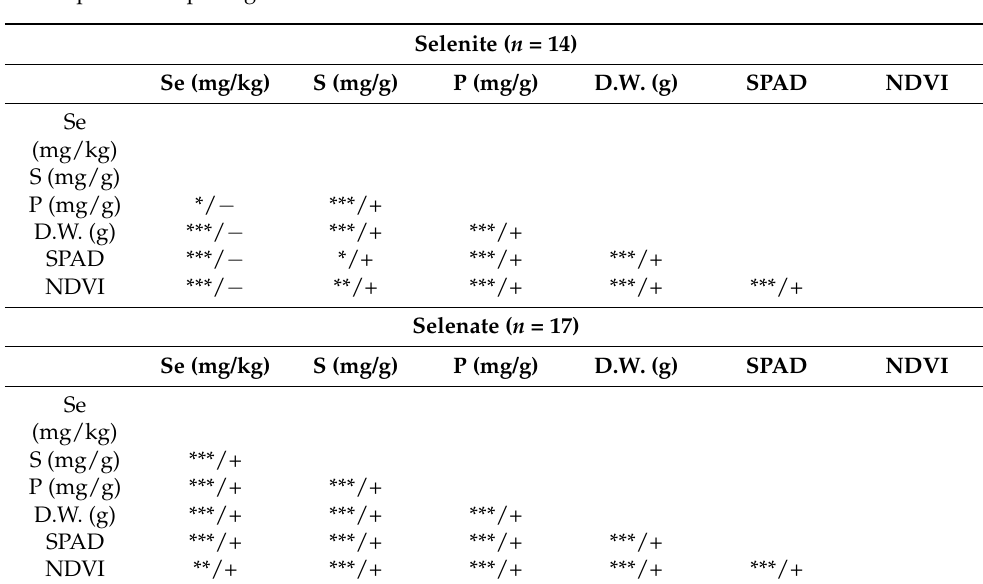
Table 3. Significant correlations between selenium (Se), phosphorus (P), sulfur (S) concentrations in lettuce plants and plant growth